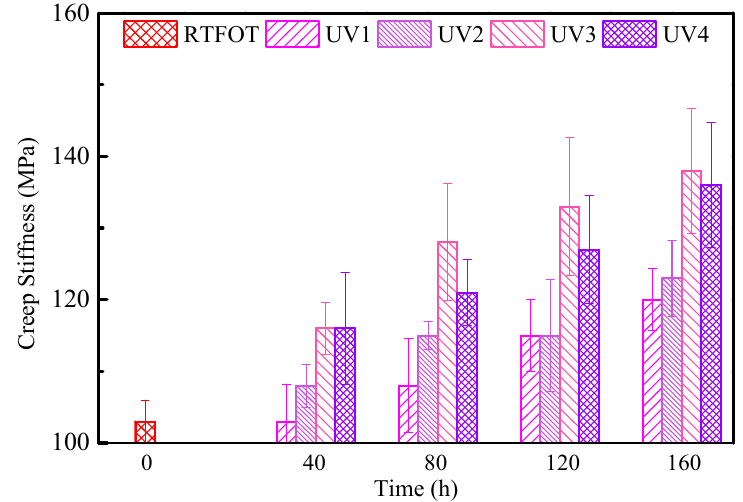
Figure 6. Creep stiffness ( S value) of SBS-modified asphalt binders under UV and Rolling Thin Film Oven Test (RTFOT) aging.